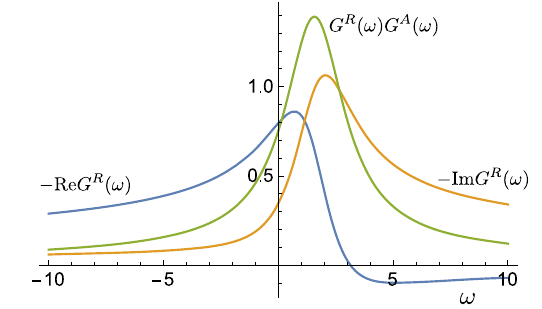
increases. In black hole thermodynamics, the Bekenstein-Hawking entropy h ¼ A A Þ , where G = ð 4 G is Newton ’ h N b N BH